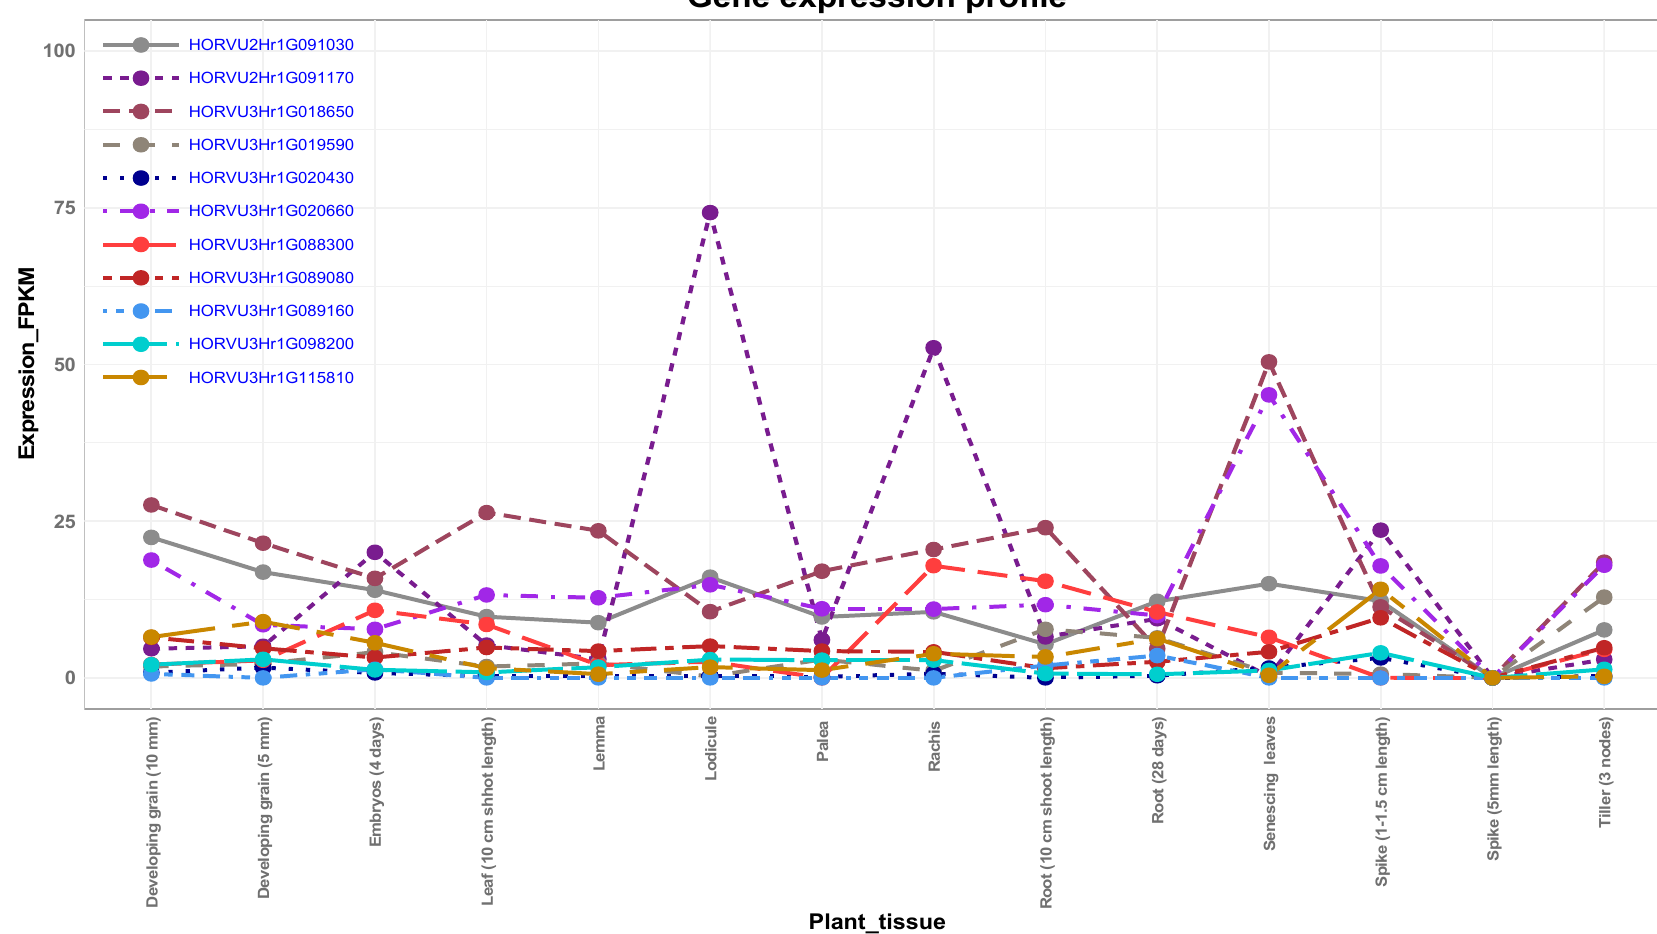
Figure 6. Expression analysis of the candidate genes in different plant organs at different developmental stages.